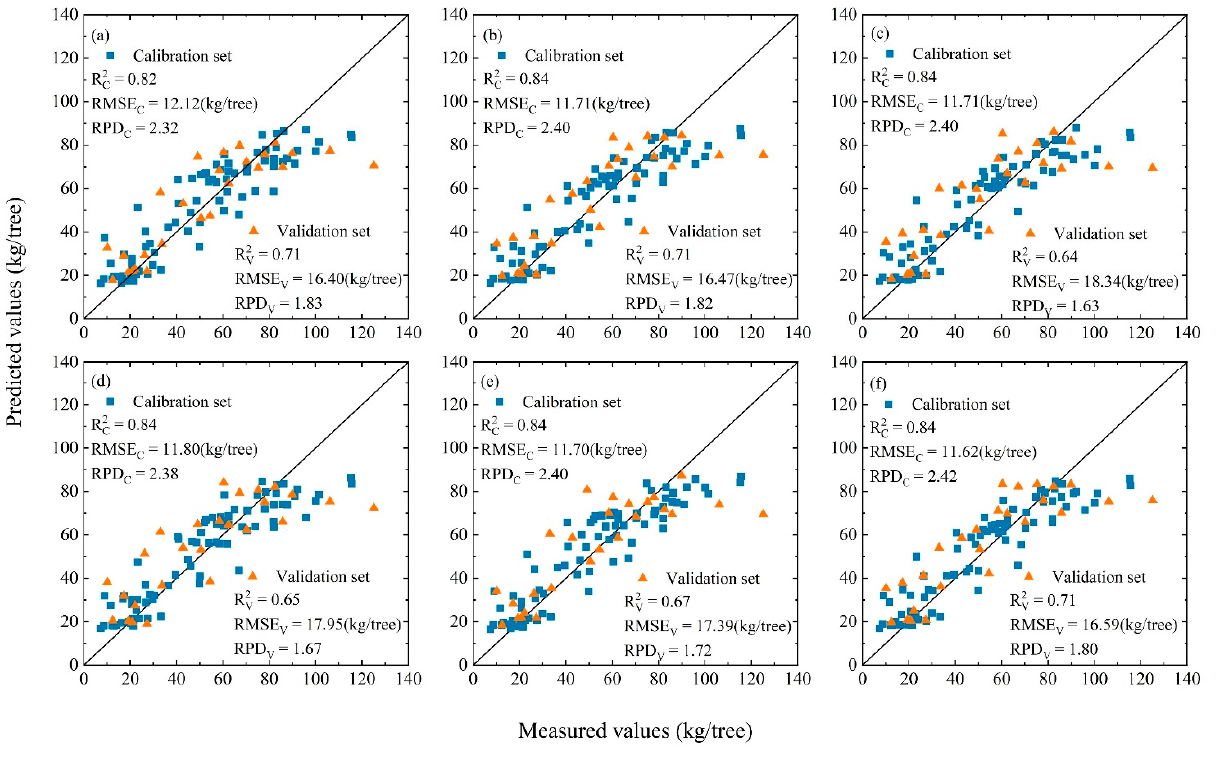
Figure 5. Calibration and validation results of the yield prediction model based on ∑ Vis: ( a ) the RF ∑ NDVI model, ( b ) the RF ∑ SAVI model, ( c ) the RF ∑ EVI model, ( d ) the RF ∑ DVI model, ( e ) the RF ∑ SR model, and ( f ) the RF ∑ RDVI model.